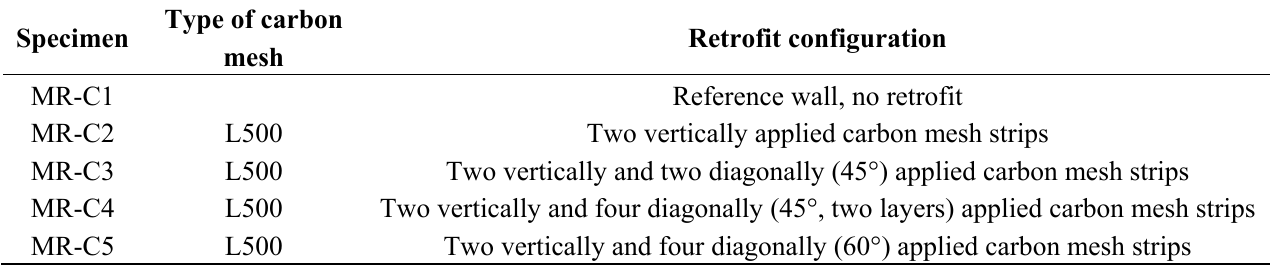
Table 2. Tested configurations of retrofitted masonry walls in Series